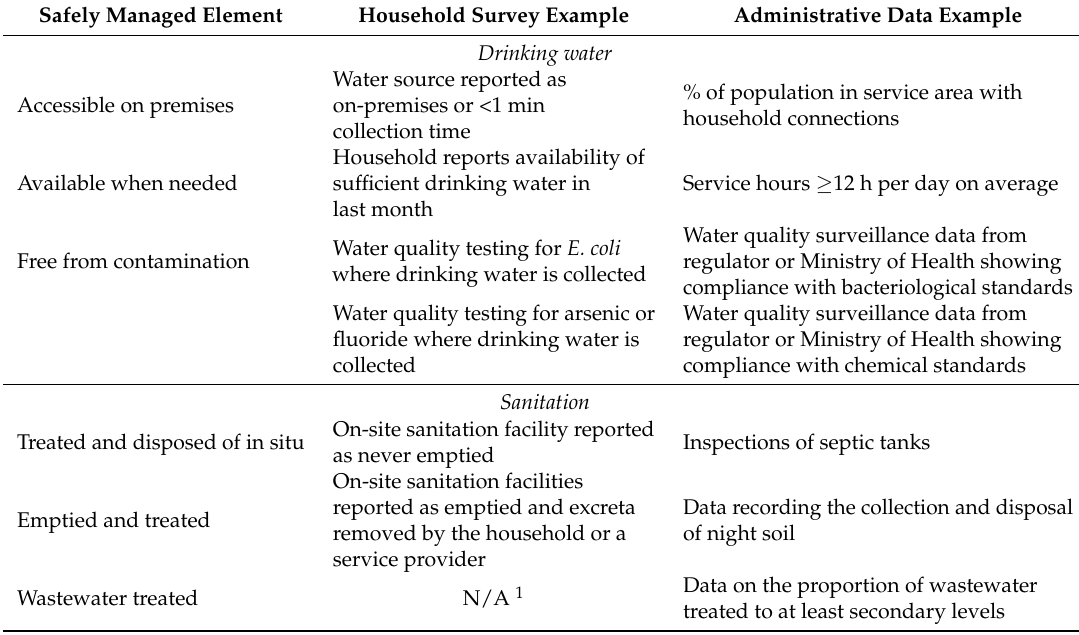
Table 3. Safely managed elements and examples from household surveys and administrative